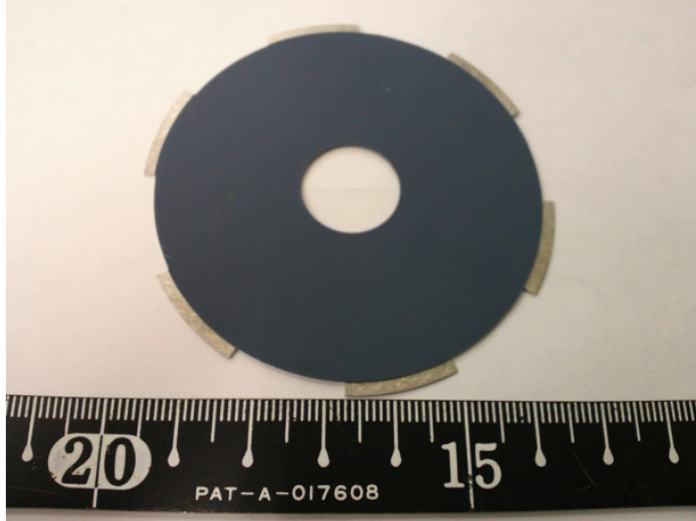
Figure 1. Photo of an electro-adhesive (EA) gel.